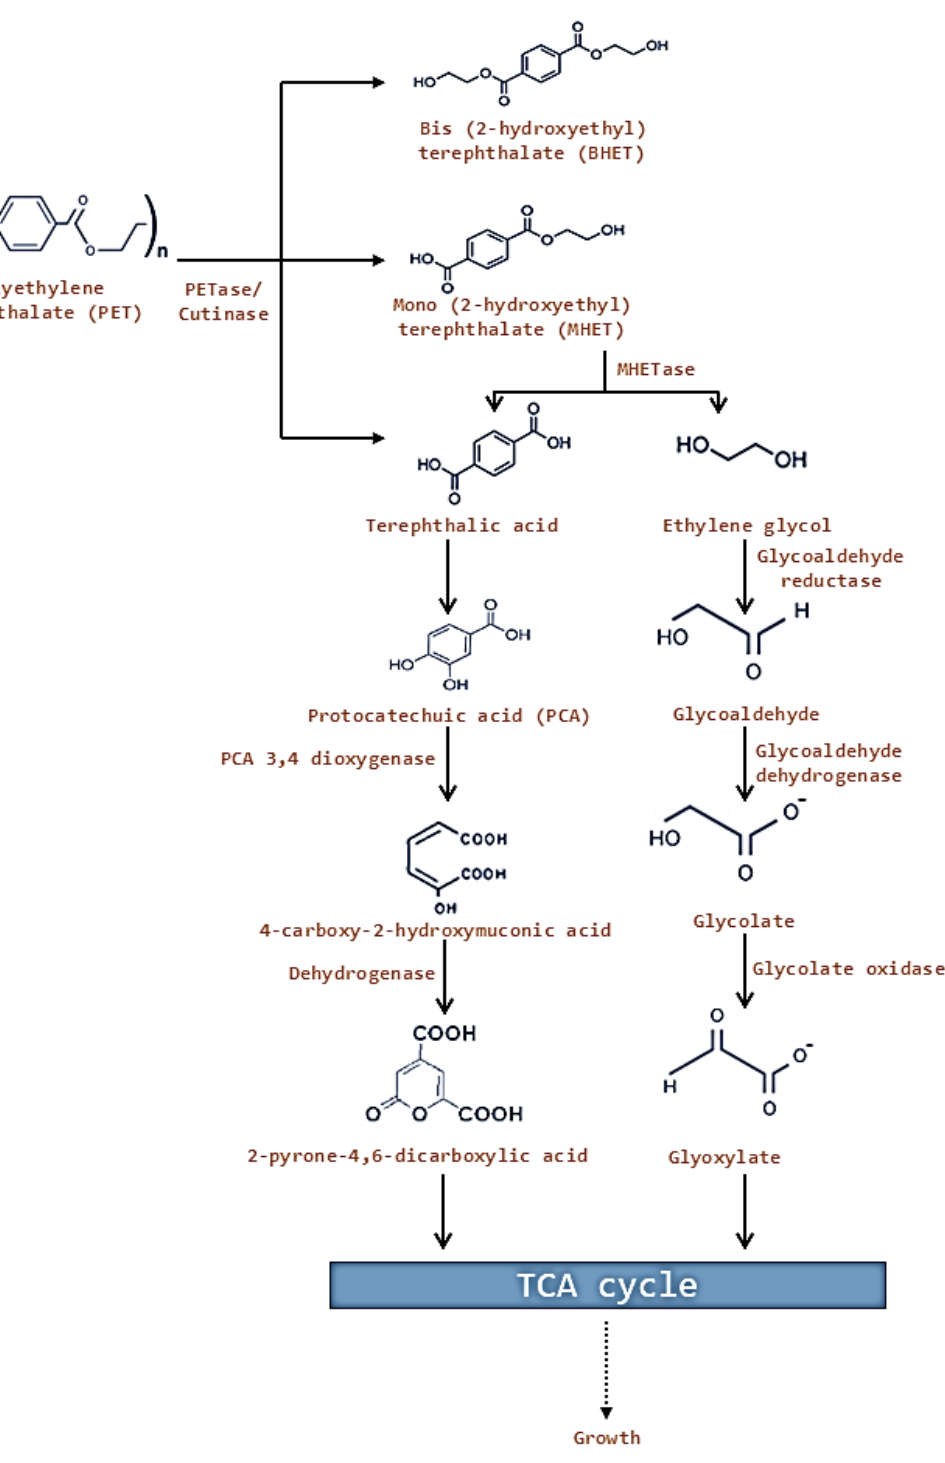
Figure 5. Enzymatic reactions involved in biodegradation of PET. The biodegradation of PET is stated with the enzyme PETase, and, subsequently, the by-product enters into TCA cycle to culminate energy.